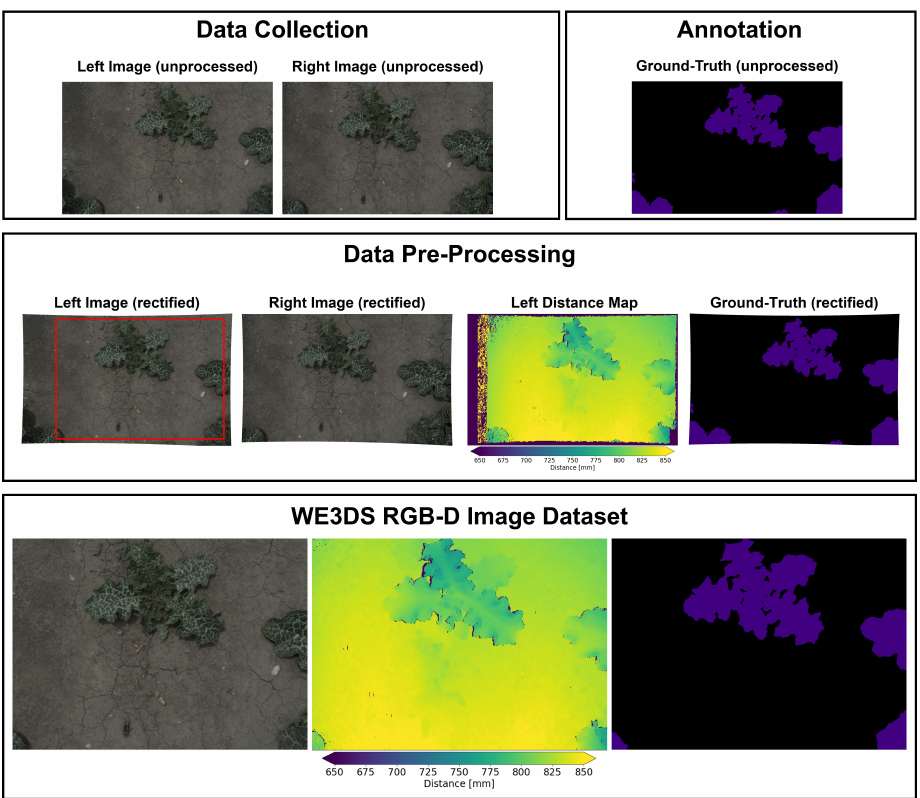
Figure 2. Overview of workflow including data collection ( top, left ), ground-truth annotation ( top, right ), data pre-processing ( middle ) and a final data point within the WE3DS RGB-D image dataset. The red rectangle in the left rectified image indicates the region of interest for the RGB-D image